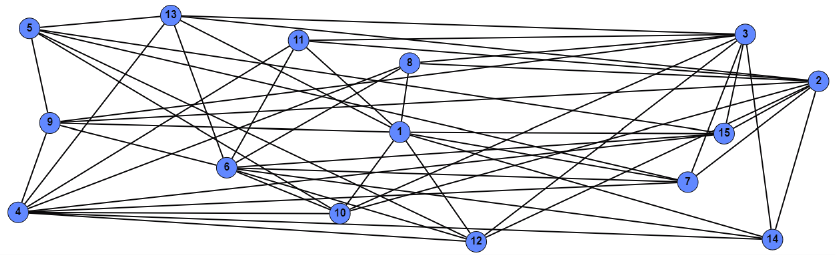
Figure 5. Intuitionistic fuzzy graph.